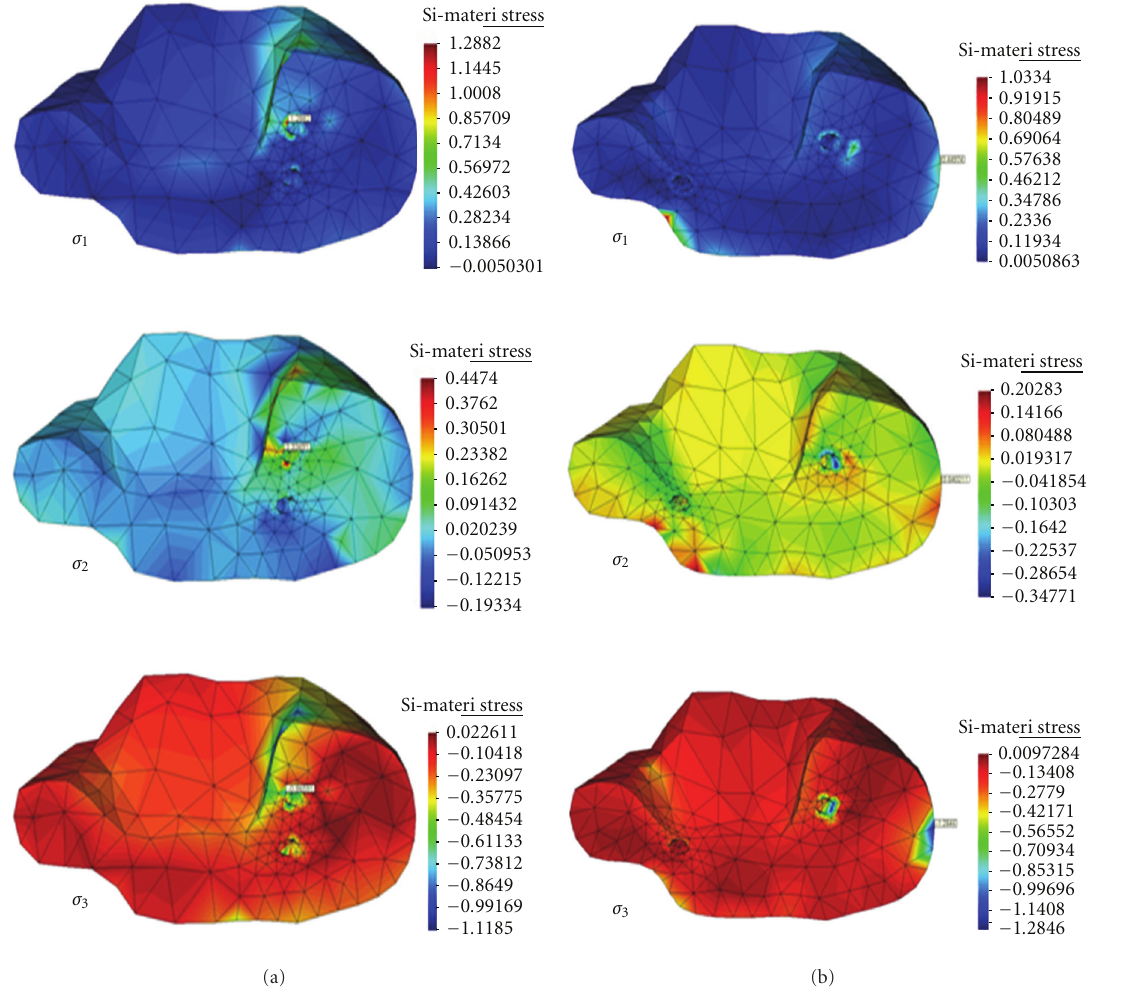
Figure 10: Predicted normal principal stress contours σ 1 , σ 2 , and σ 3 for bottom fracture for normal load of 50N along lateral x -direction, (a) parallel K-wire fixation. (b) crossing K-wire fixation.